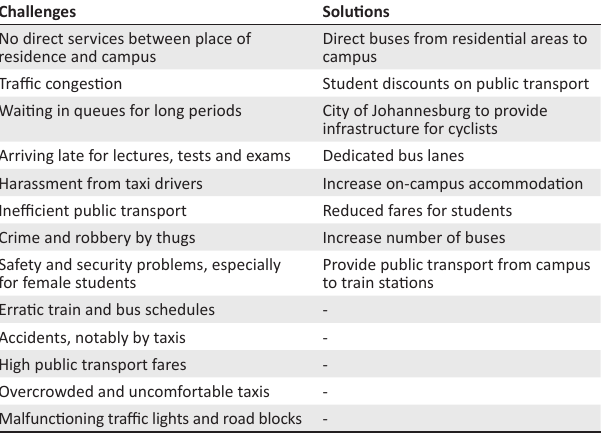
TABLE 2: Challenges experienced by students and their